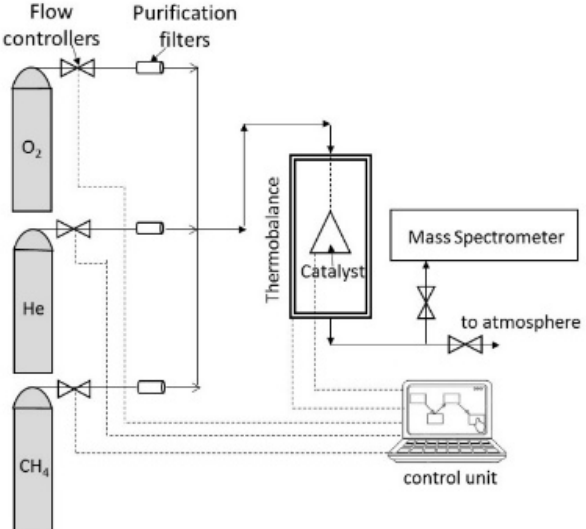
Figure 1. Schematic diagram of the experimental setup used for the reaction-thermogravimetric ex- periments.